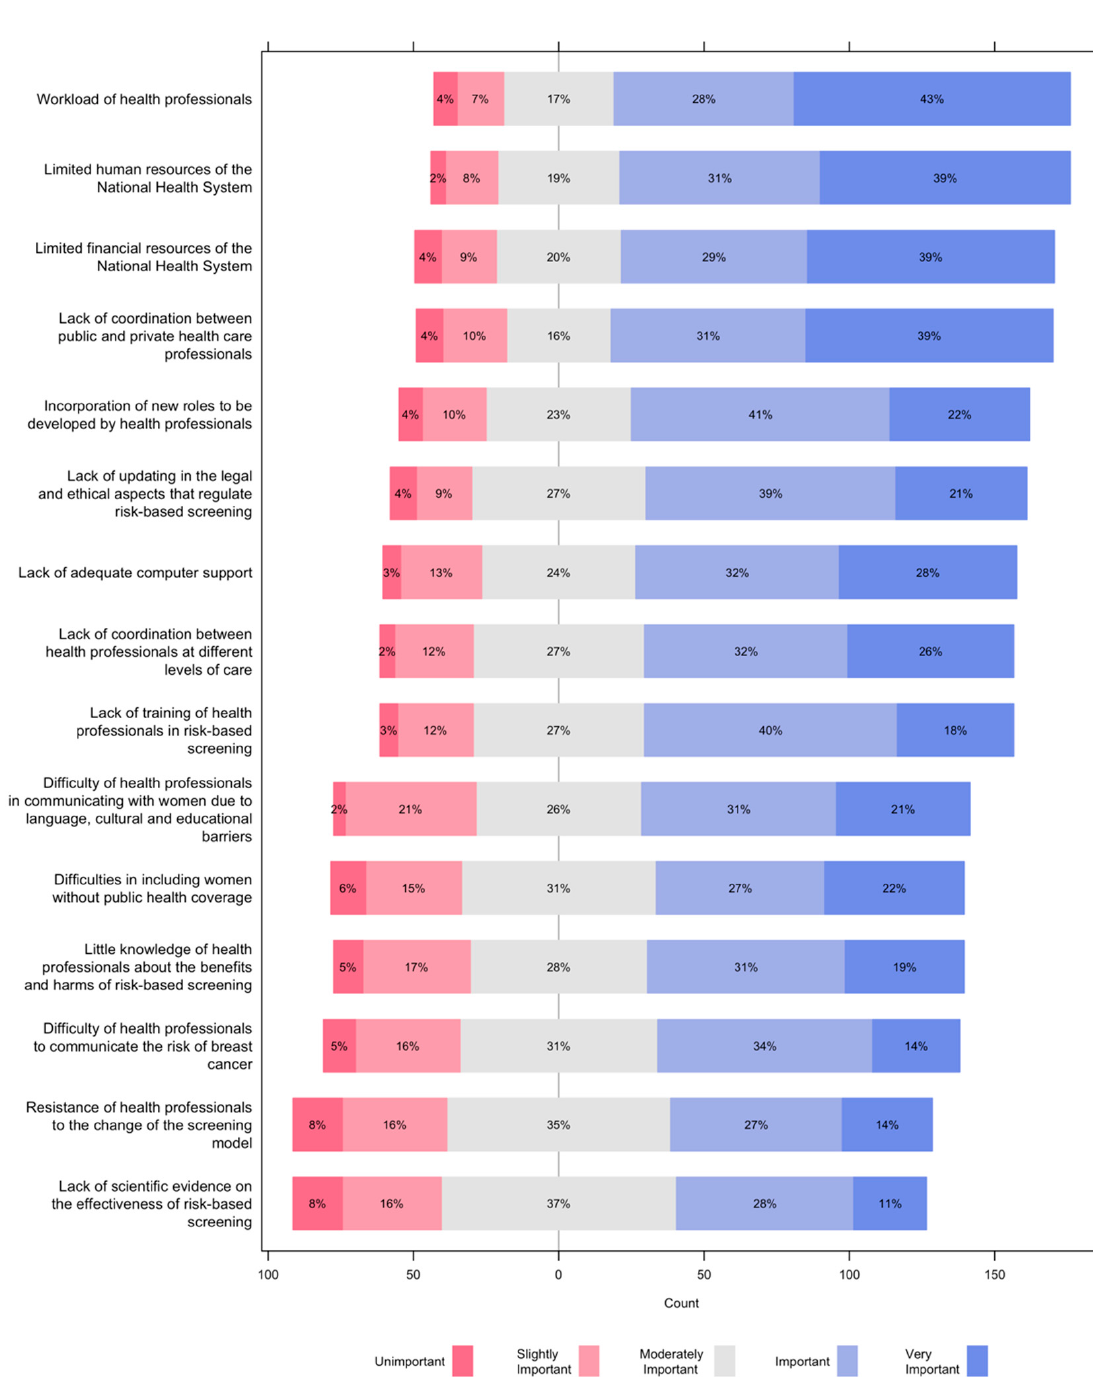
Figure 5. Barriers to the implementation of a risk-based screening program.